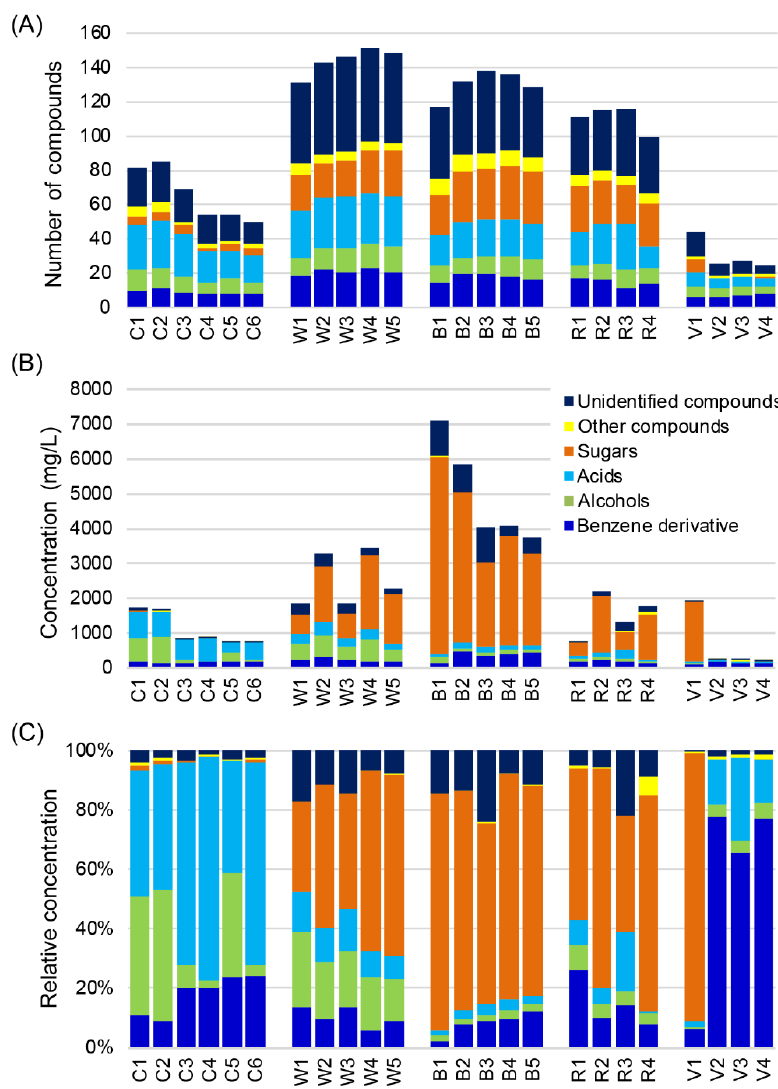
Figure 2. Non-volatile organic compounds (non-VOCs) in distilled liquors detected by GC-TOFMS. ( A ) Number of compounds in major classes of non-VOCs in 24 representative distilled liquors. ( B ) Contents of major classes of non-VOCs. ( C ) Relative concentrations of major classes of non-VOCs.